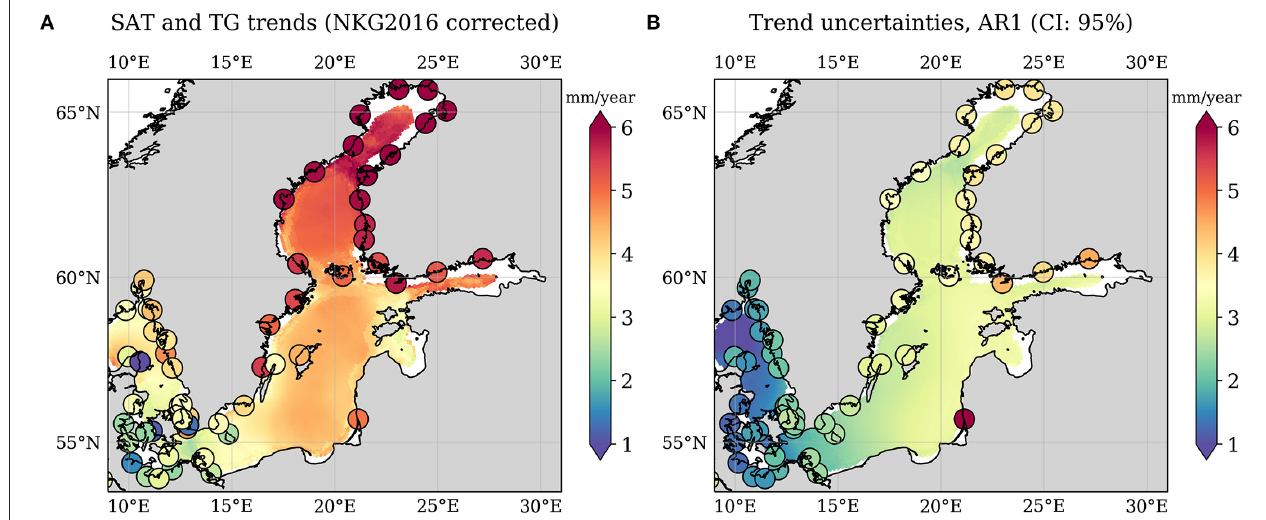
FIGURE 4 | SL trends (A) and corresponding uncertainties (B) estimated by altimetry (shading) and TGs (circles) from May 1995 to May 2019. TGs are corrected for the GIA using the NKG2016 model. Uncertainties are reported as 95% confidence interval.